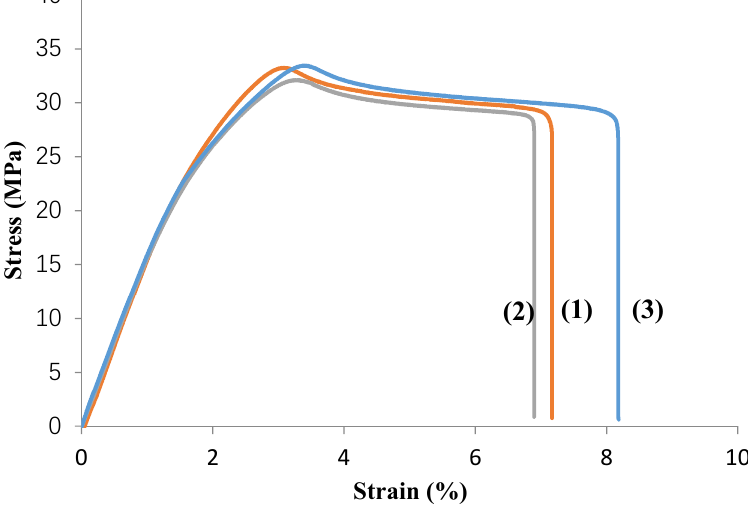
Figure 1. Stress-strain curves, for the Extrudr BDP Flax material, experiment no. 6.